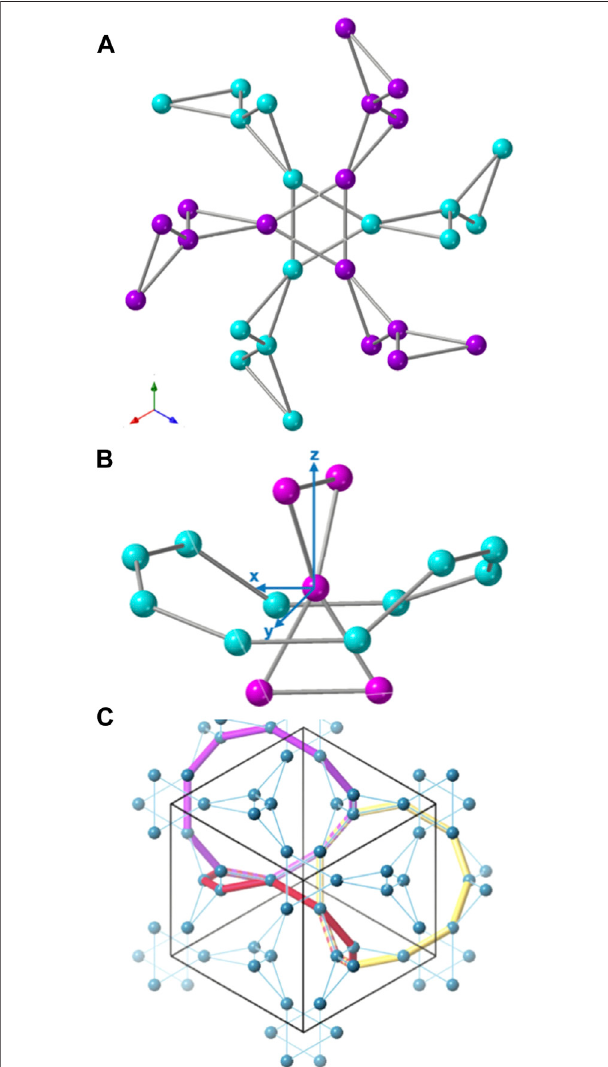
FIGURE 3 | (A) Interpenetrating hyperkagome lattice of the rare earth ions on the rare earth garnet lattice along the [1 1 1] direction. (B) Ten ion loop inthegarnetsurroundingacentral rareearthion. (C) Connectedten-ionloops of rare earth atoms [7].